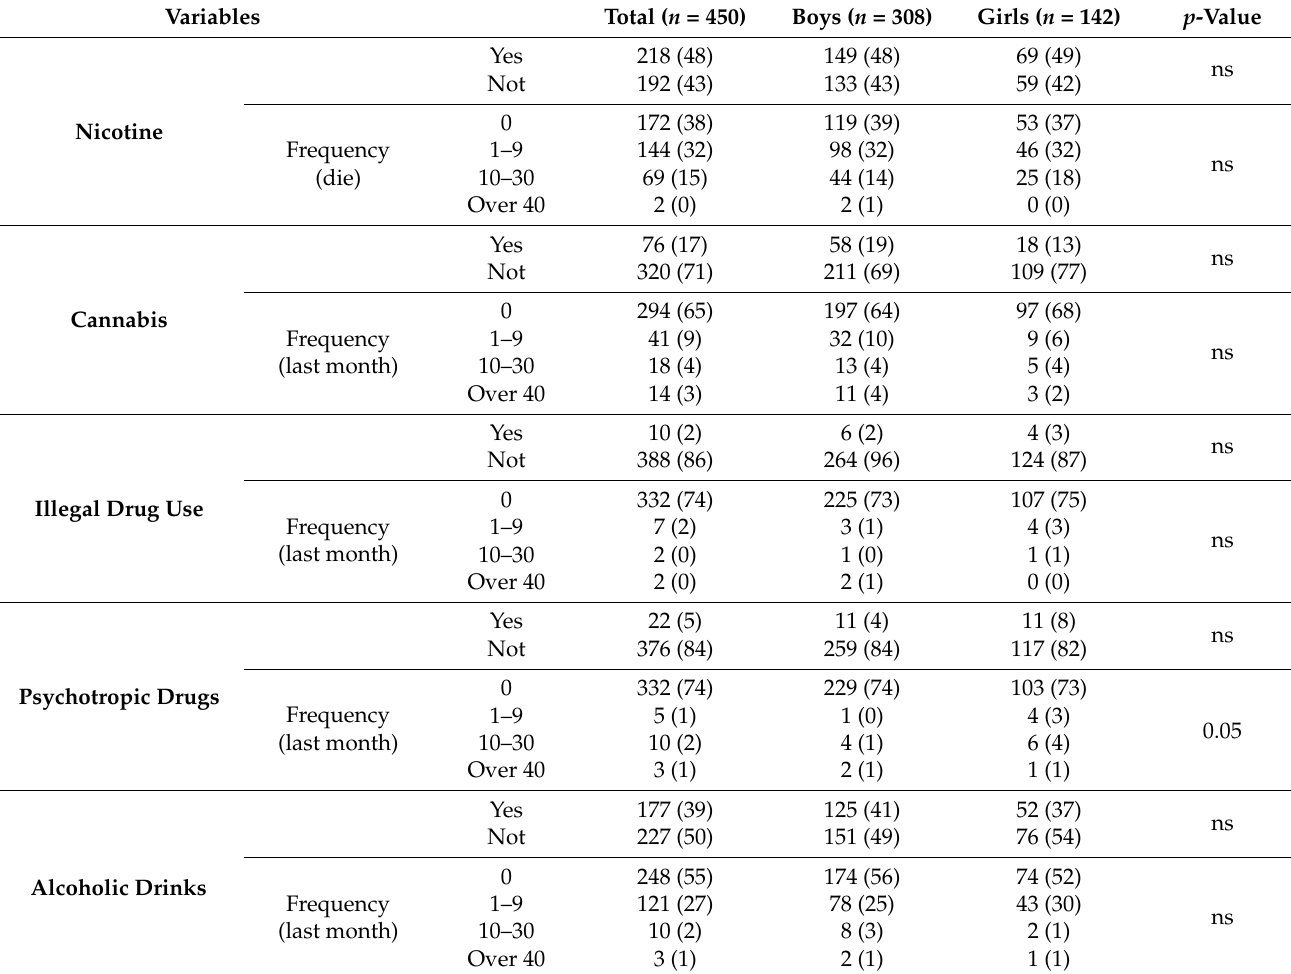
Table 1. Substance use and abuse in total population and by gender.